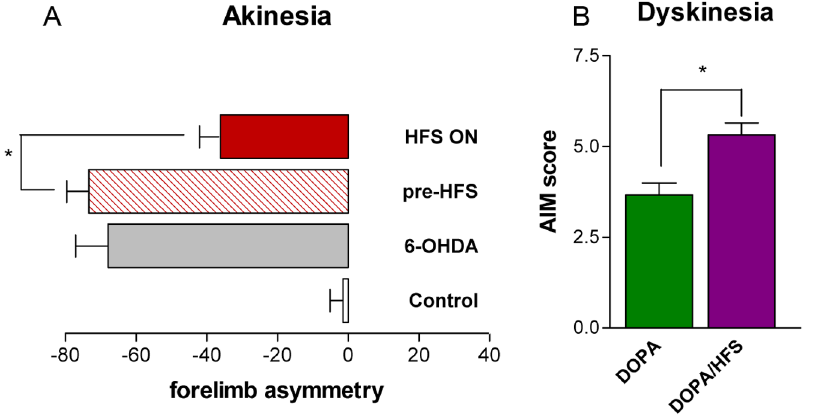
Figure 2. STN HFS alleviates akinesia and exacerbates L-DOPA-induced dyskinesia. (A) Akinesia was assessed by forelimb asymmetry in the cylinder test in the control and 6-OHDA groups and in the HFS group before the stimulation (pre-HFS) and after 5 days of stimulation (HFS-ON). Forelimb asymmetry was calculated as the % contralateral minus % ipsilateral forepaw contacts (*p , 0.05 HFS ON vs. pre-HFS). (B) Analysis of AIMs was performed in DOPA and DOPA/HFS groups. Dyskinesia score corresponds to the sum of the orolingual and forelimb AIM scores (maximum 8). The data are the means 6 SEM, * p , 0.05 DOPA/HFS vs DOPA.